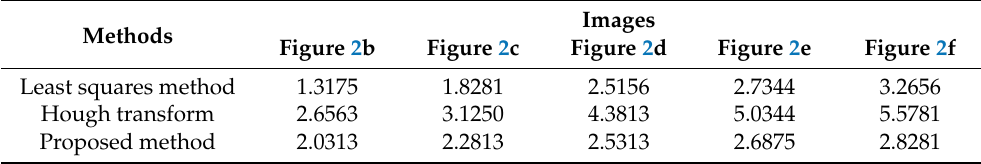
Table 2. The diameter of the circular hole obtained by different algorithms (mm) lists look like this. Methods Least squares